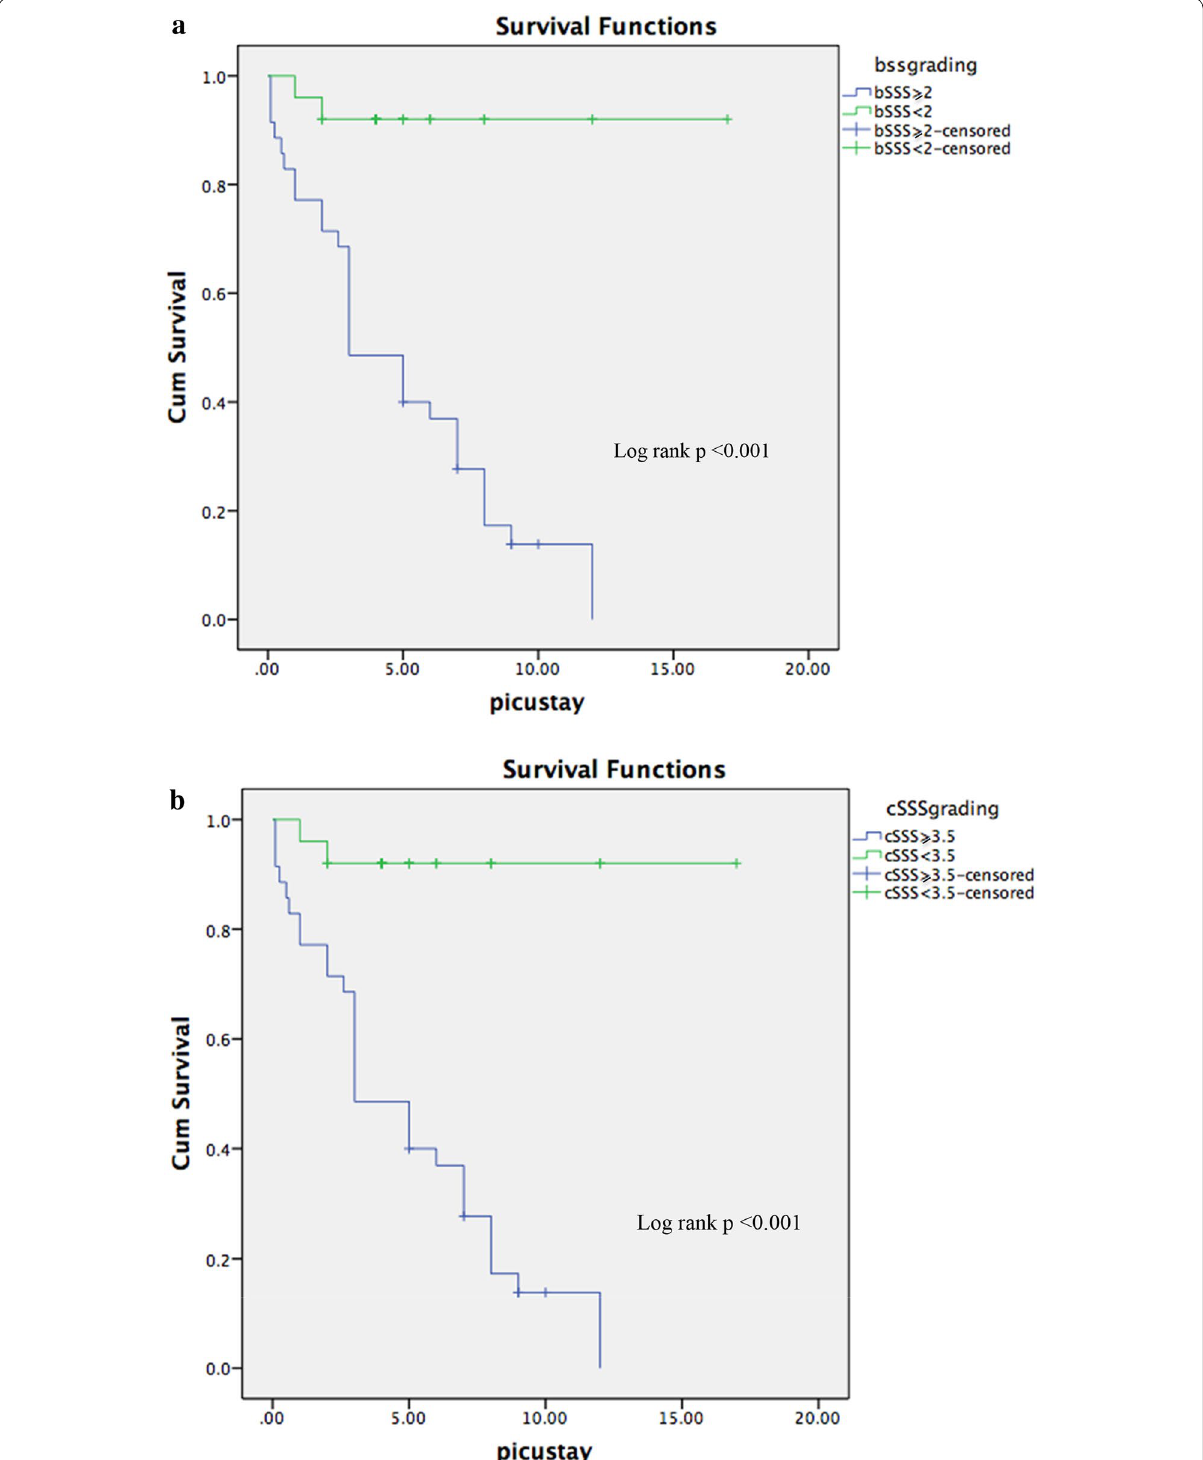
Fig. 1 a Survival curve of refractory septic shock patients diagnosed with a bedside septic shock score shock patients diagnosed with a computed septic shock score